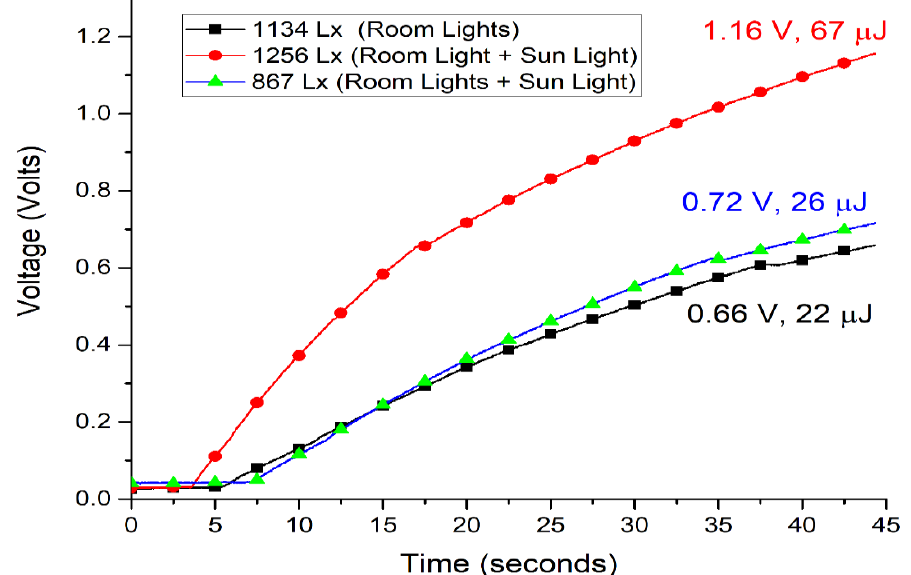
Figure 10. Charging of the 100 uF capacitor by the BQ25504 converter under different light conditions (room light and hybrid light conditions).